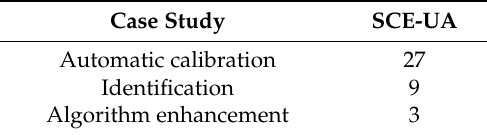
Table 1. Applications of shuffled complex evolution (SCE-UA) algorithm during the last eight